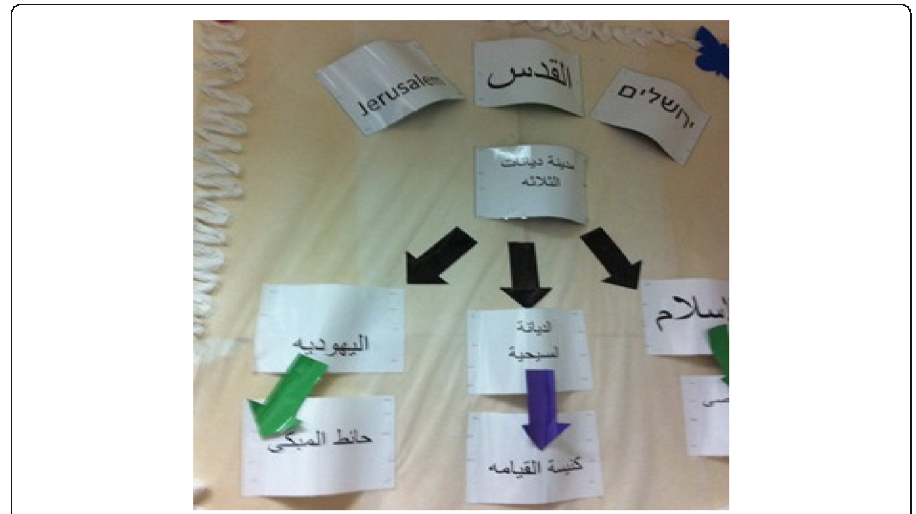
Fig. 7 Arabic-Hebrew-English schoolscape